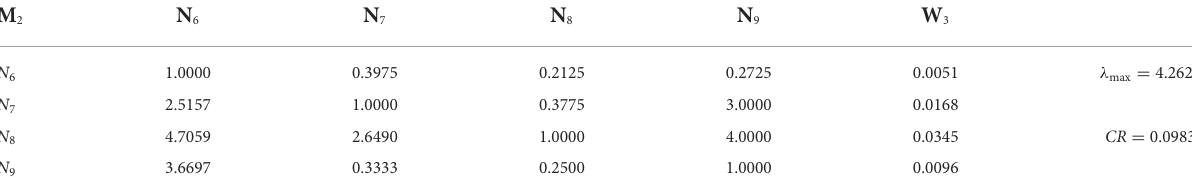
TABLE 6 Product design criteria judgment matrix consistency ratio and its